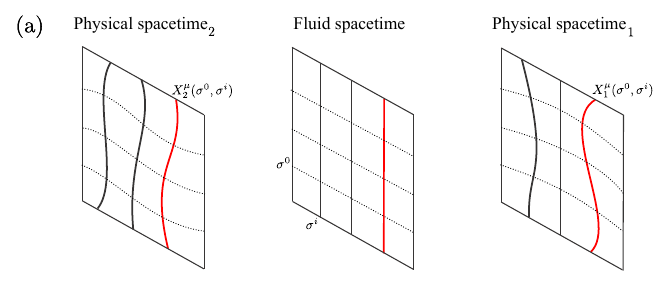
Figure 1 . Relations between the fluid spacetime and two copies of physical spacetimes. The red straight line in the fluid spacetime with constant σ i is mapped by X µ 1 trajectories (also in red) of the corresponding fluid